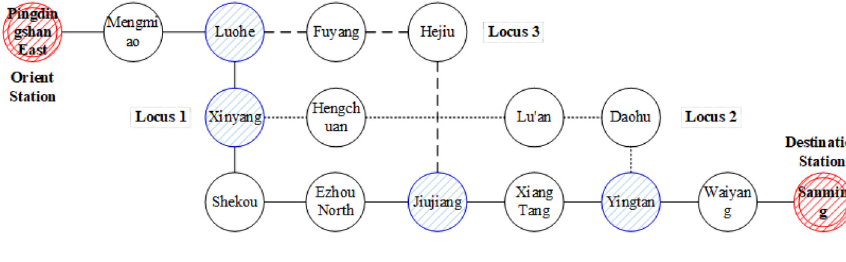
Figure 2. The daily